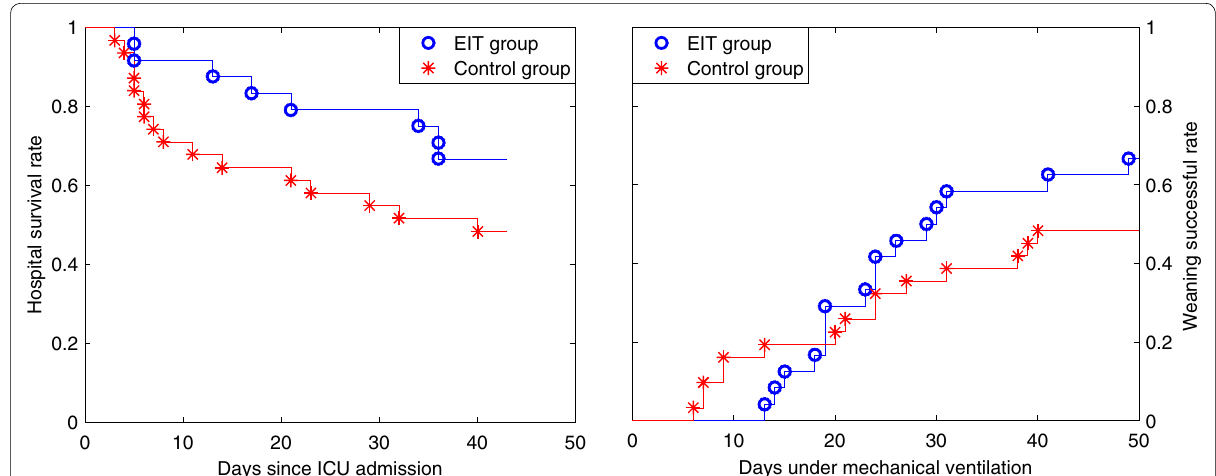
Fig. 3 Hospital survival (left) and weaning success curves (right) of EIT group (blue circles) and control group (red asterisk). For the hospital survival curves, day 0 is the day of ICU admission. If a patient survived and was discharged from hospital, he was not censored but counted as survival